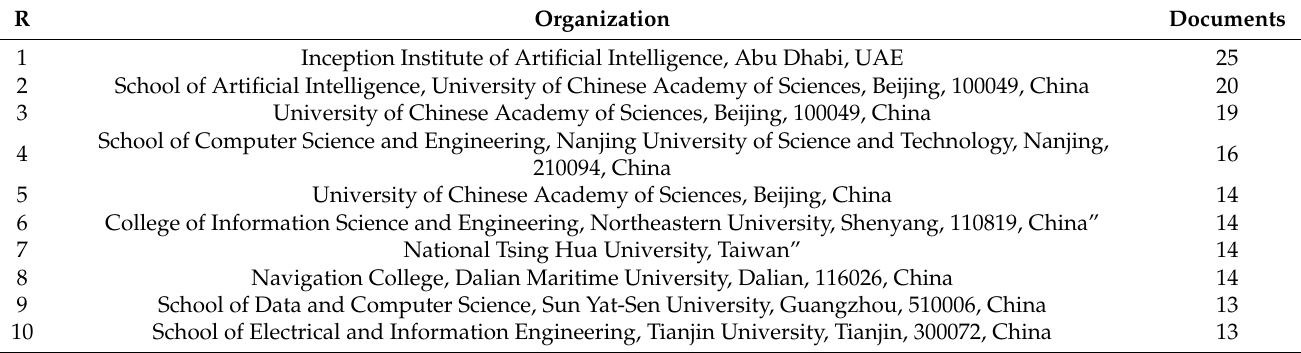
Table 5. Most productive organizations in the leading AI journals during (2020 and